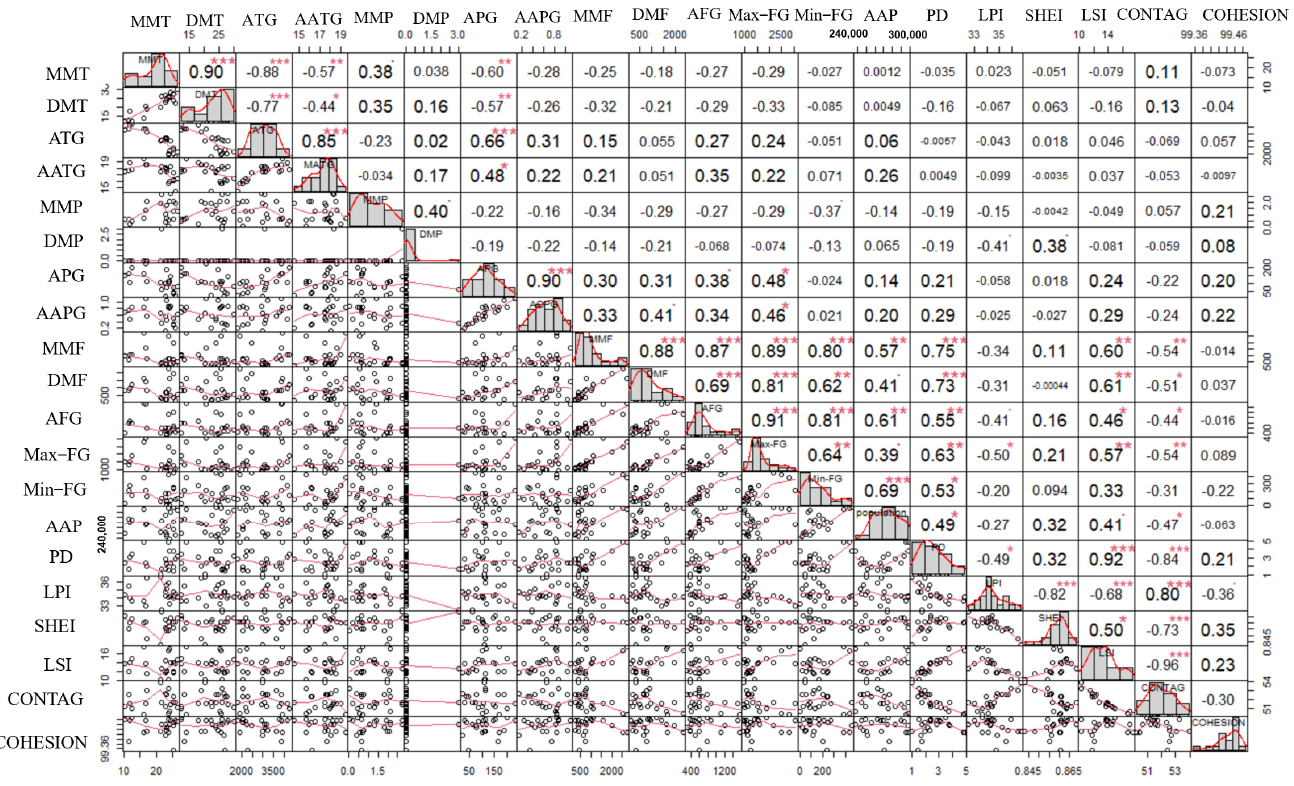
Figure 12. Correlation analysis between wetland landscape pa tt ern and in fl uencing factors (* means p < 0.5, ** means p < 0.01, *** means p <